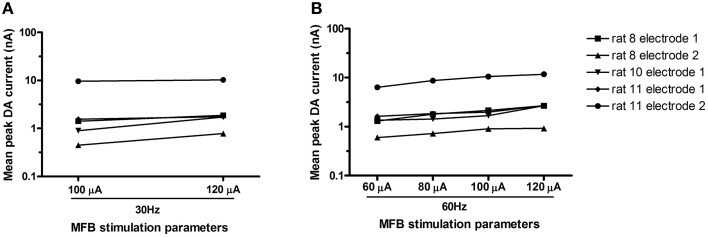
Mean peak DA current (log) for each electrode (n = 5 electrodes) across various stimulation parameters. At both frequencies tested [30 Hz–(A); 60 Hz–(B)], peak DA current increased with current (respectively: Wilcoxon, p < 0.05; Friedman, p = 0.002).